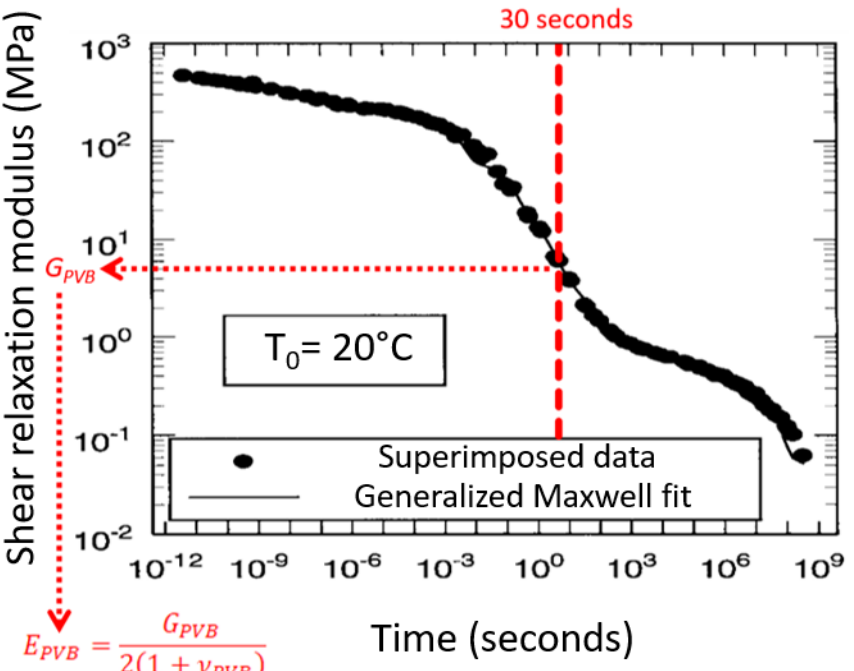
Figure 5. Example of practical derivation of equivalent shear relaxation modulus for PVB interlayer based on experimental master-curve (original figure adapted from [40] under permission from John Wiley and Sons©, Copyright license number 5327091377077, June 2022).